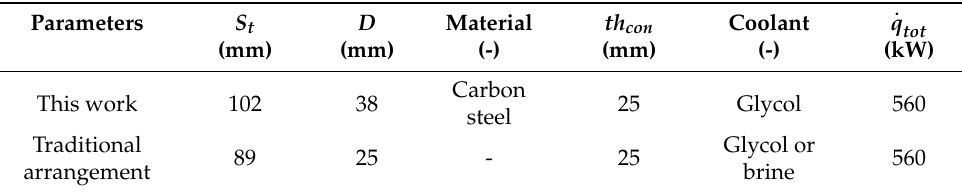
Table 3. The best practical ice rink floor